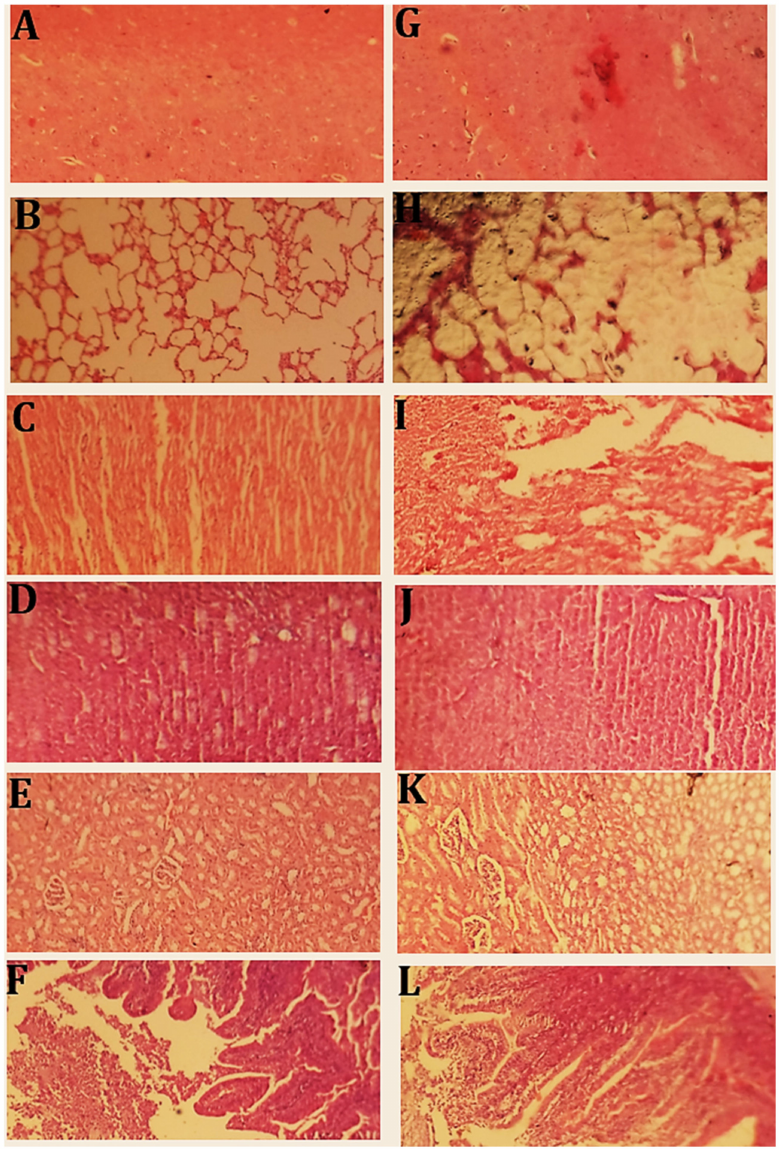
Figure 12. Histopathological examination of ( A ) = brain (control), ( G ) = brain (treated), ( B ) = lungs (control), ( H ) = lungs (treated), ( C ) = heart (control), ( I ) = heart (treated), ( D ) = liver (control), ( J ) = liver (treated), ( E ) = kidney (control), ( K ) = kidney (treated), ( F ) = intestine (control), ( L ) = intestine